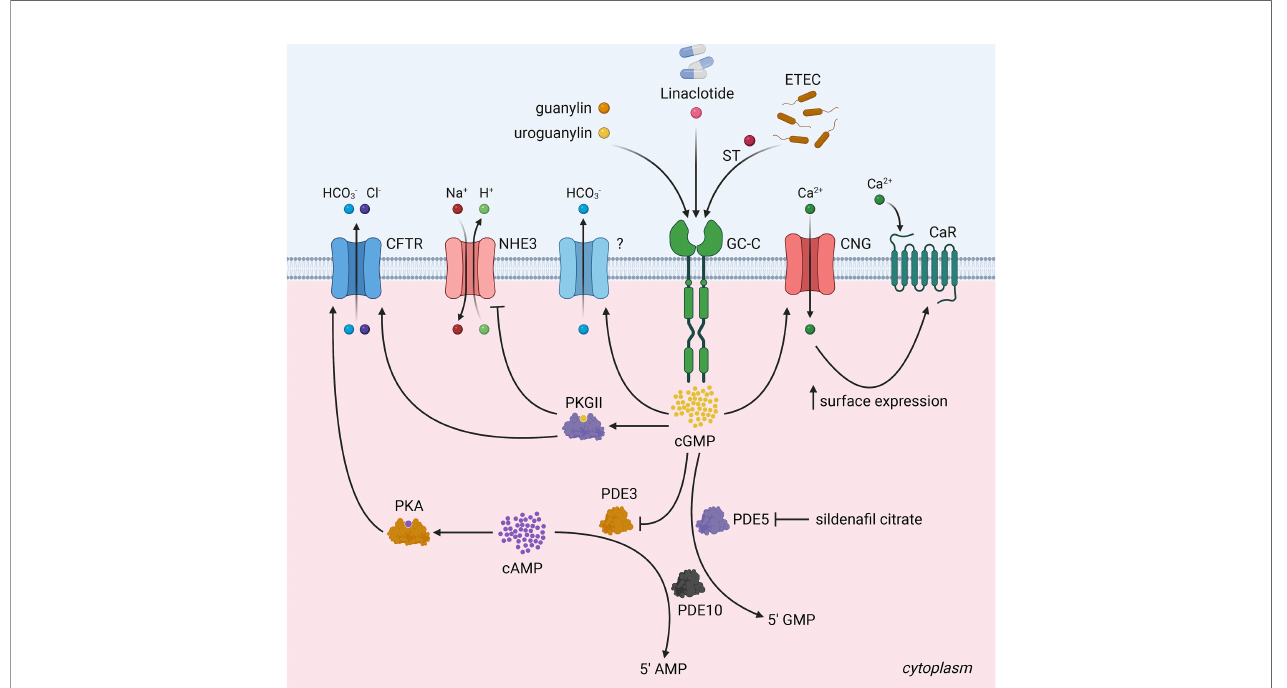
FIGURE 3 | The GC-C/cGMP signaling axis and fl uid-ion homeostasis in the intestine. Binding of ligands (heat-stable enterotoxin/ST) produced by enterotoxigenic E.coli and the endogenous hormones guanylin and uroguanylin) to GC-C catalyzes the formation of cGMP from GTP. Increased intracellular cGMP levels result in the activation of cGMP-dependent protein kinase II (PKGII) and the inhibition of cAMP-speci fi c phosphodiesterase (PDE3), which in turn leads to the cross-activation of cAMP-dependent protein kinase (PKA). Reduced intestinal sodium absorption is caused by PKGII-mediated inhibitory phosphorylation of NHE3. PKGII and PKA phosphorylated and activate the cystic fi brosis transmembrane conductance regulator (CFTR) anion channel, increasing intestinal chloride and water secretion. Elevated intracellular cGMP increases duodenal bicarbonate secretion via CFTR and perhaps additional unknown mechanisms. Increased cGMP activates cyclic nucleotide-gated ion channels (CNG), promoting Ca 2+ -in fl ux, which recruits calcium-sensing G-protein coupled receptors (CaR) to the plasma membrane. PDE5, a cGMP-dependent phosphodiesterase, and PDE10 hydrolyze cGMP to 5 ’ GMP to attenuate GC-C signaling. Pharmacological GC-C agonists (e.g., linaclotide) and cGMP-speci fi c phosphodiesterase PDE5 antagonists (e.g., sildena fi l citrate) increase intracellular cGMP levels suggesting, that they may have a synergistic antiproliferative effect and reduce the likelihood of resistance to both drugs in colorectal cancer. The fi gure was prepared using